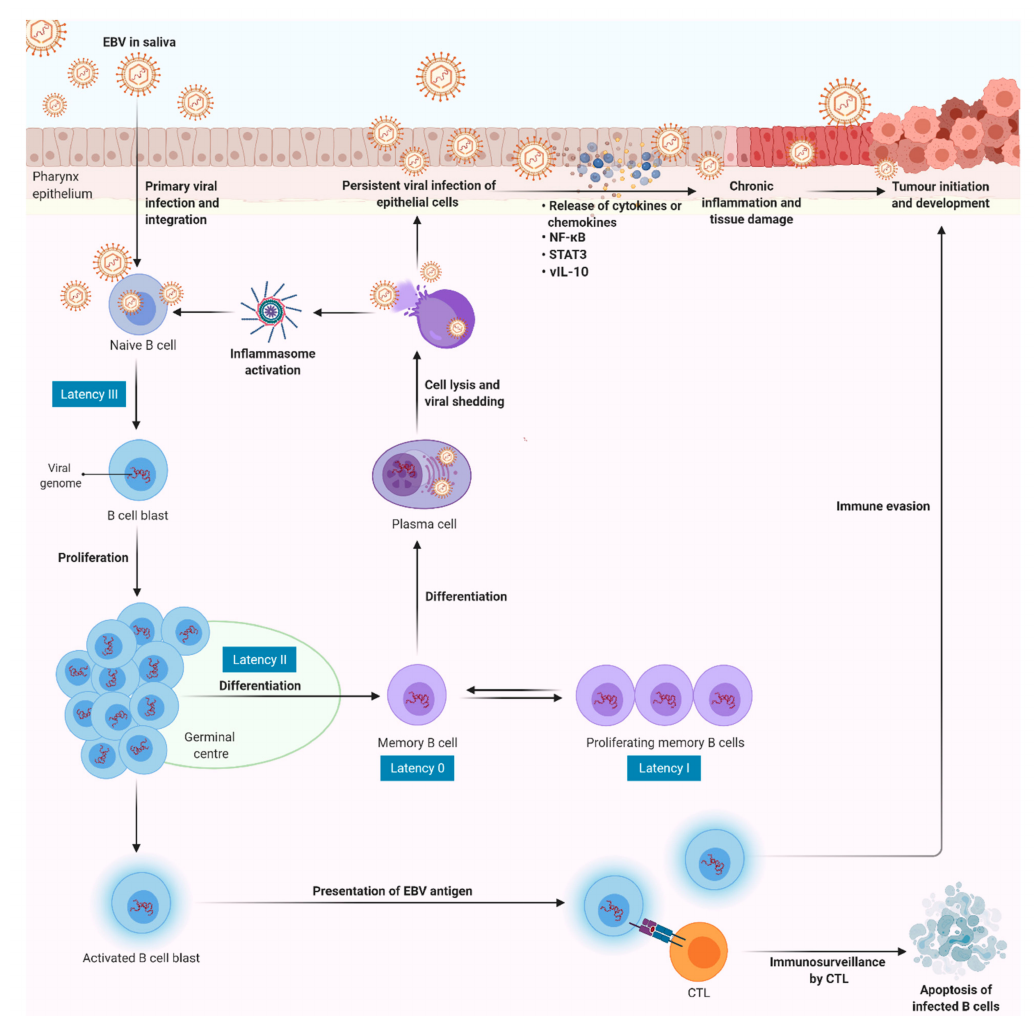
Figure 5. Overview of EBV-induced inflammation and NPC carcinogenesis. EBV in saliva passes through pharynx epithelium to infect naive B cells in the underlying lymphoid tissue via interaction of the viral glycoprotein gp350/220 with CD21 expressed on the B cells. This in turn drives the formation of proliferating lymphoblasts. Once EBV enters the cell, the viral capsid dissolves and viral genome incorporated into the host nucleus. The B cell blasts can differentiate into memory compartment as resting, long-lived, memory B cells with no viral gene expression. Furthermore, EBV encodes vIL-10 to escape host anti-viral responses and to establish latency by enhancing viability and differentiation of infected B cells. The latently infected memory B cells circulate in the periphery and return to the lymphoid tissue, where they can be signalled by cognate antigen to differentiate into plasma cells and activate viral replication program to produce more infectious virus. The lysis of infected cells leads the release of virion to initiate a new round of naïve B cell infection or infect the epithelial cells. Additionally, the plasma membrane break induces the efflux of potassium ion that activates inflammasome. Sustained inflammasome activation may promote viral replication and persistent infection. During a persistent infection, infected cells secrete excessive amount of pro-inflammatory cytokines/chemokines via NF- κ B and STAT3 signalling, in order to establish a chronic inflammatory microenvironment that persistently damage the surrounding tissue. Over time, the chronic inflammation may trigger the initiation and development of cancer. In immunocompetent individuals, effective CTLs can recognise infected cells through the presentation of EBV antigen via MHC Class I and eliminate them by apoptosis. However, immune incompetent individual may be at risk of developing EBV-associated tumour during the chronic inflammation. (EBV, Epstein–Barr virus; NF- κ B, nuclear factor kappa B; STAT3; signal transducer and activator of transcription 3; CTLs, cytotoxic T lymphocytes; MHC, major histocompatibility complex; vIL-10, viral